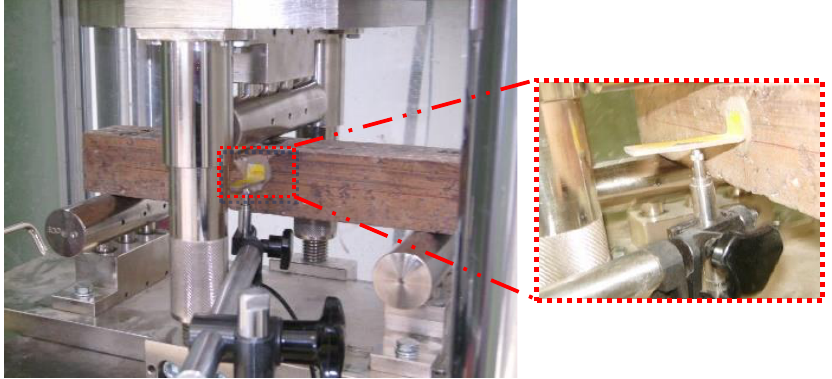
Figure 1. Details of bending test apparatus.